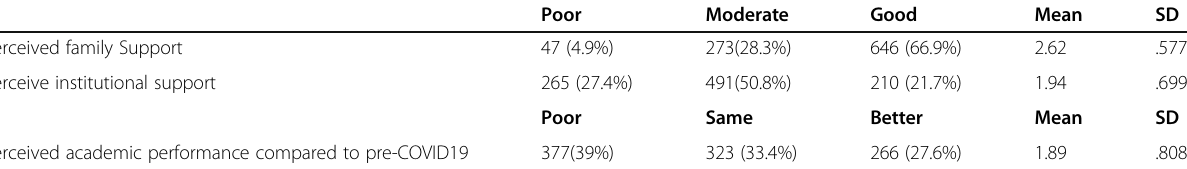
Table 3 Students perceived family support, institutional support and academic performance ( N = 966)